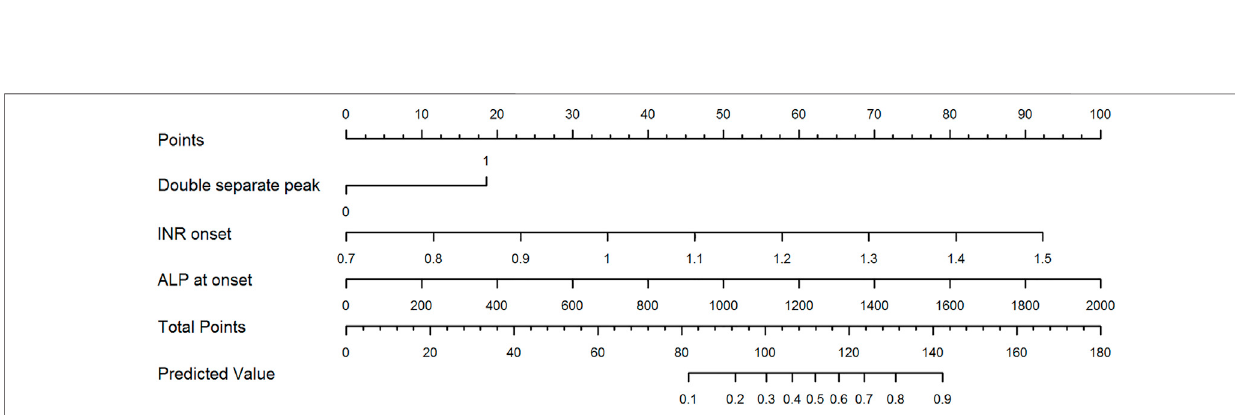
Frontiers in Pharmacology |